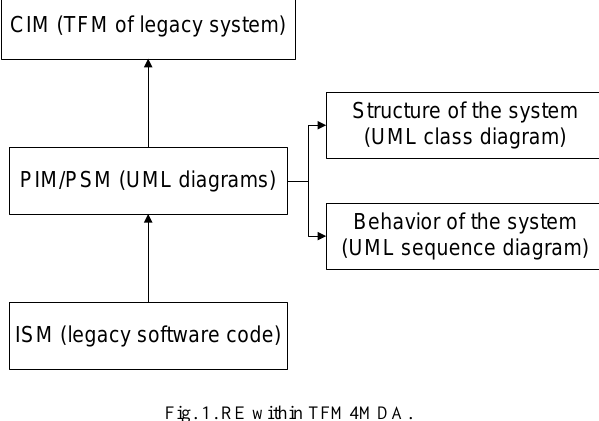
Fig. 1. RE within TFM4MDA.